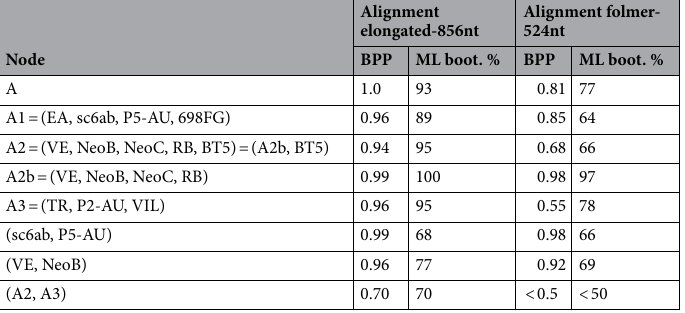
Table 4. Bayesian posterior probability (BPP) and ML bootstrap percentage for the nodes within clade A shown in Figs. 2 and